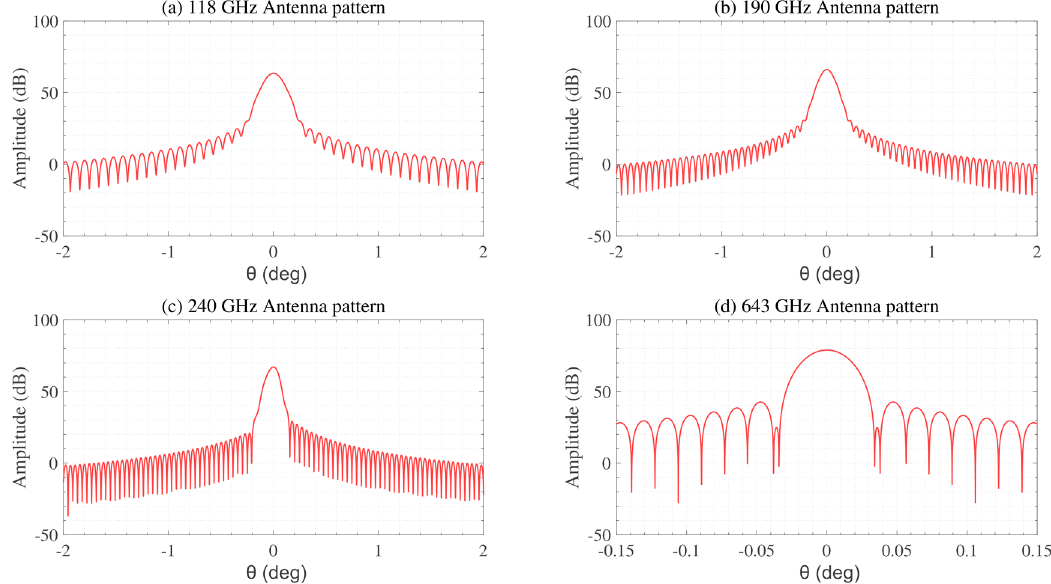
Figure 3. The antenna pattern of TALIS: ( a ) the 118 GHz antenna pattern; ( b ) the 190 GHz antenna pattern; (c) the 240 GHz antenna pattern; ( d ) the 643 GHz antenna pattern.